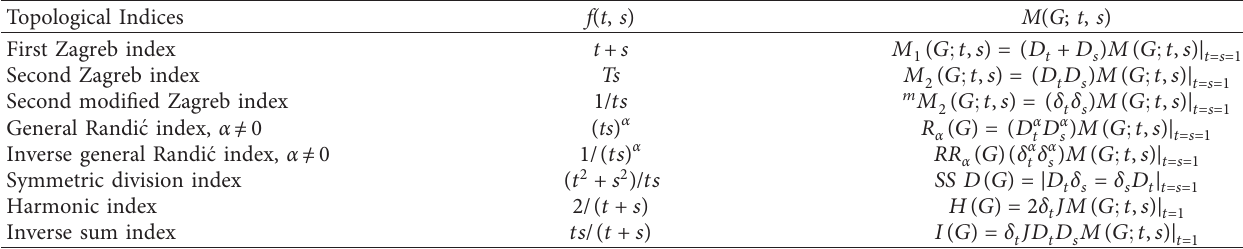
Table 1: Formulas of degree-based topological indices from